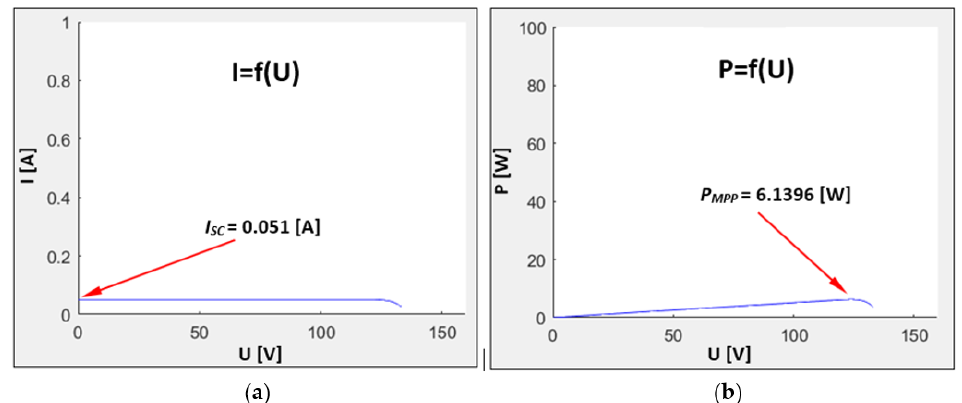
Figure 10. Simulation results for irradiance of 300 W/m 2 deflected by an angle Δ θ = 10° from the direction of perpendicular incidence and a temperature of 21 °C for the modeled CX-75/200 module: ( a ) current–voltage characteristics I = f(U); ( b ) power graph P = f(U).